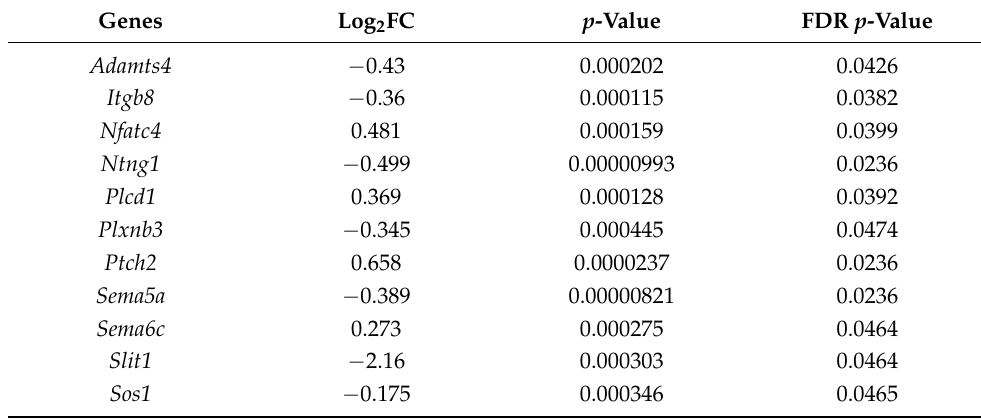
Table 4. Axonal guidance signaling genes in Homo PKC γ